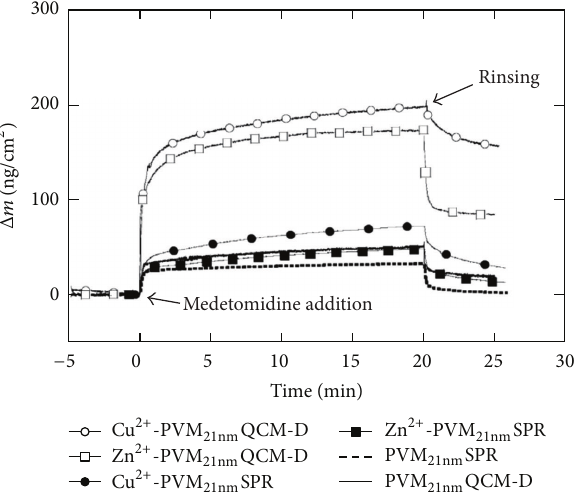
Figure 6: Medetomidine absorption (measured using QCM-D and SPR) to a Cu 2+ doped, Zn 2+ doped, and metal free 21nm thick PVM film. It is apparent that metal coordination significantly enhances medetomidine adsorption and that the coordination to Cu 2+ is stronger and less reversible. Reprinted from [40]. The combination of QCM-D and SPR measurements can be used to estimate the amount of sorbed solvent in an adsorbed film. The acoustic QCM- D technique probes the entire adsorbed viscoelastic layer, including bound solvent. In contrast, the SPR method measures changes in refractive index at the surface and consequently takes only the mass of the adsorbent into account. The difference in adsorbed mass from QCM-D and SPR measurements can therefore be related to the amount of